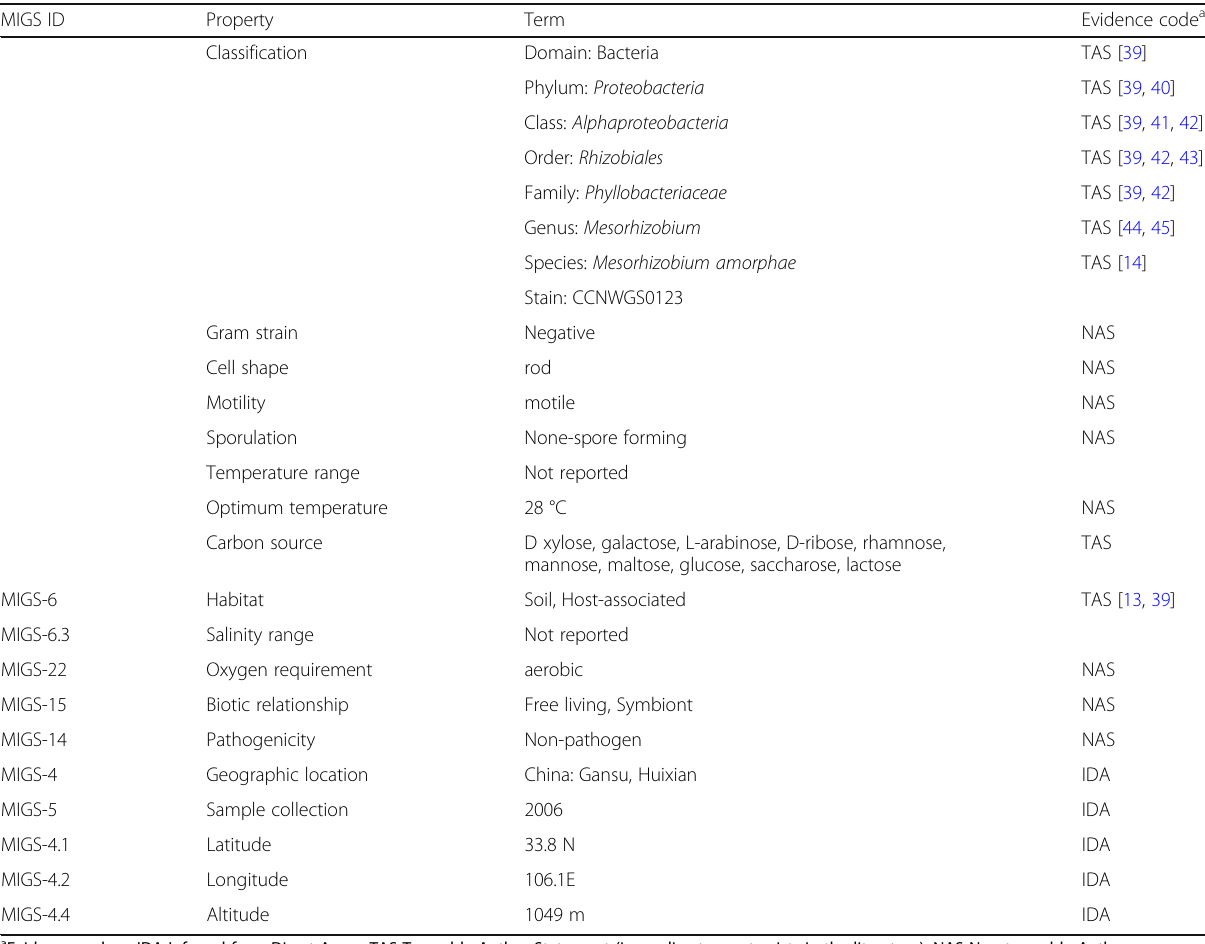
Table 1 Classification and general features of Mesorhizobium amorphae CCNWGS0123 MIGS